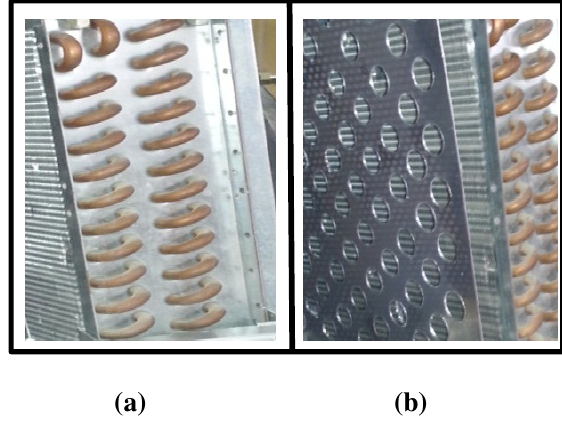
Fig. 4. Front view of the two different condensers, (a) without guide net and (b) with air guide